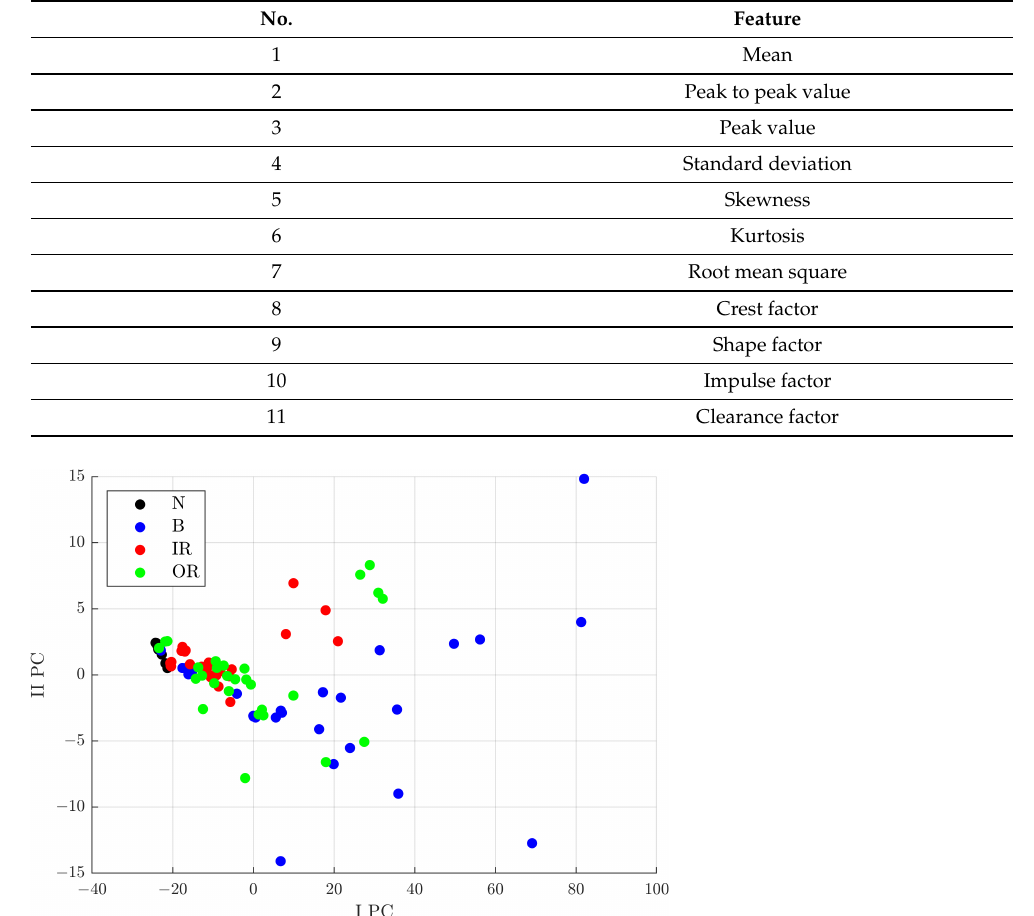
Table 6. List of time domain features extracted from the signals for the input matrix of the classifica- tion algorithm.